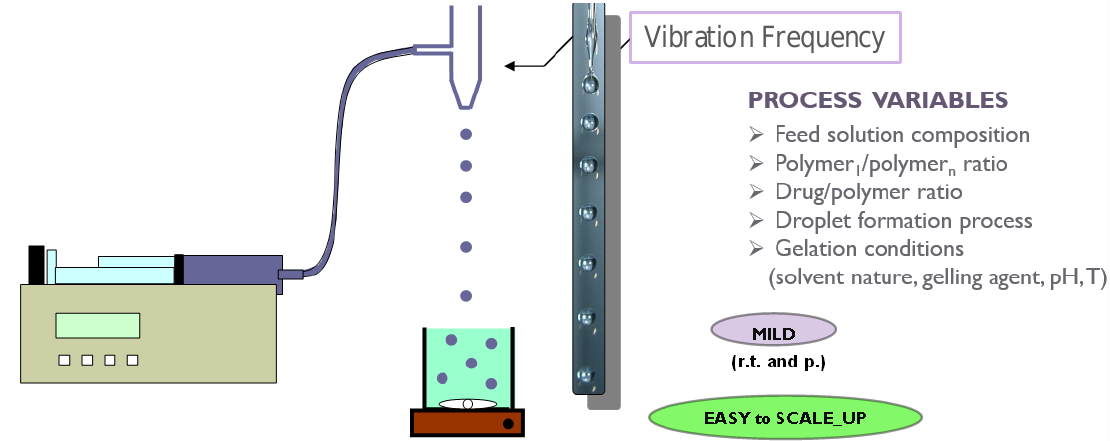
Figure 3. Schematic illustration of prilling technology with the indication of the main process variables.